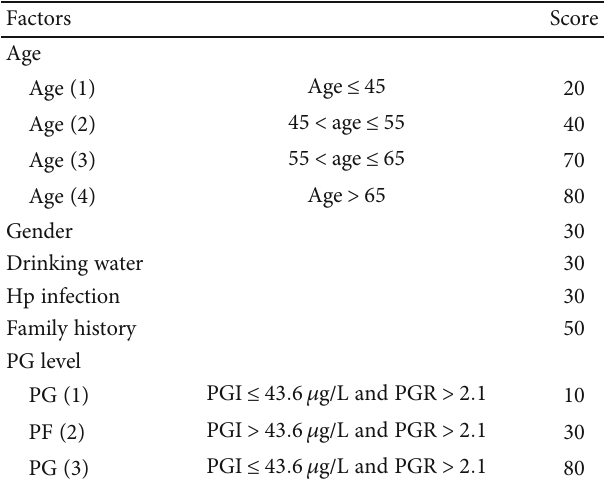
Table 5: High-risk scoring model for identi fi cation of GC and nontumor diseases of the digestive system.